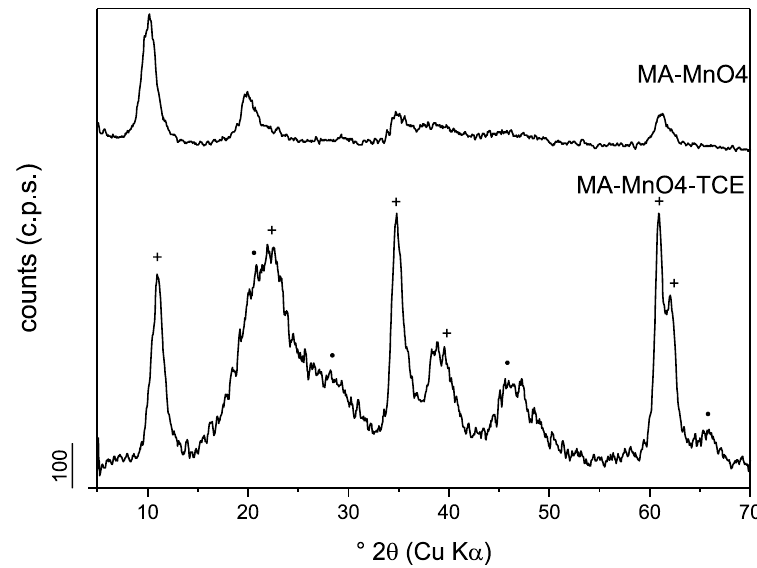
Figure 5. PXRD pattern of the used sample MA–MnO4 after the experiments using TCE ( bottom ) compared to the pattern of the unreacted raw material ( top ). ( + ) chloride intercalated Mg,Al-LDH and ( · ) MnO 2.